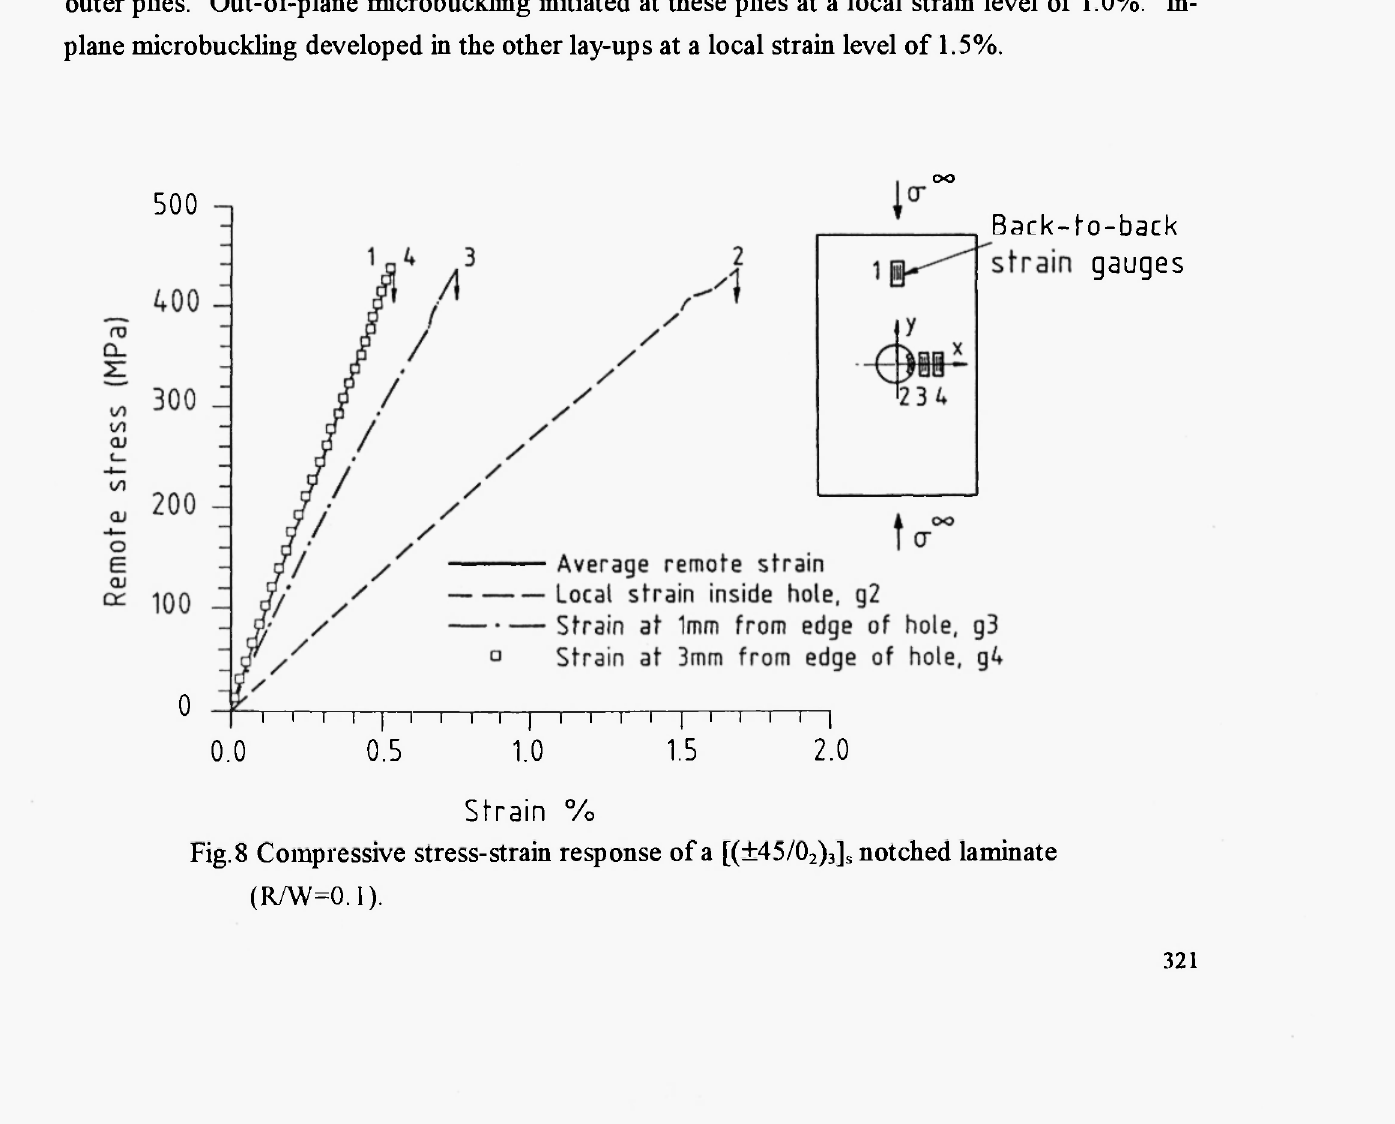
Fig. 8 Compressive stress-strain response of a [(±45/0